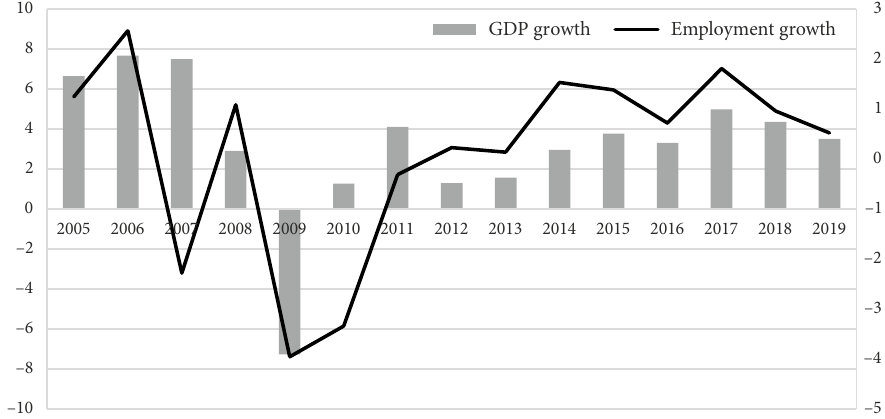
Figure 3. Growth of employment and GDP in CEE countries in years 2004–2019